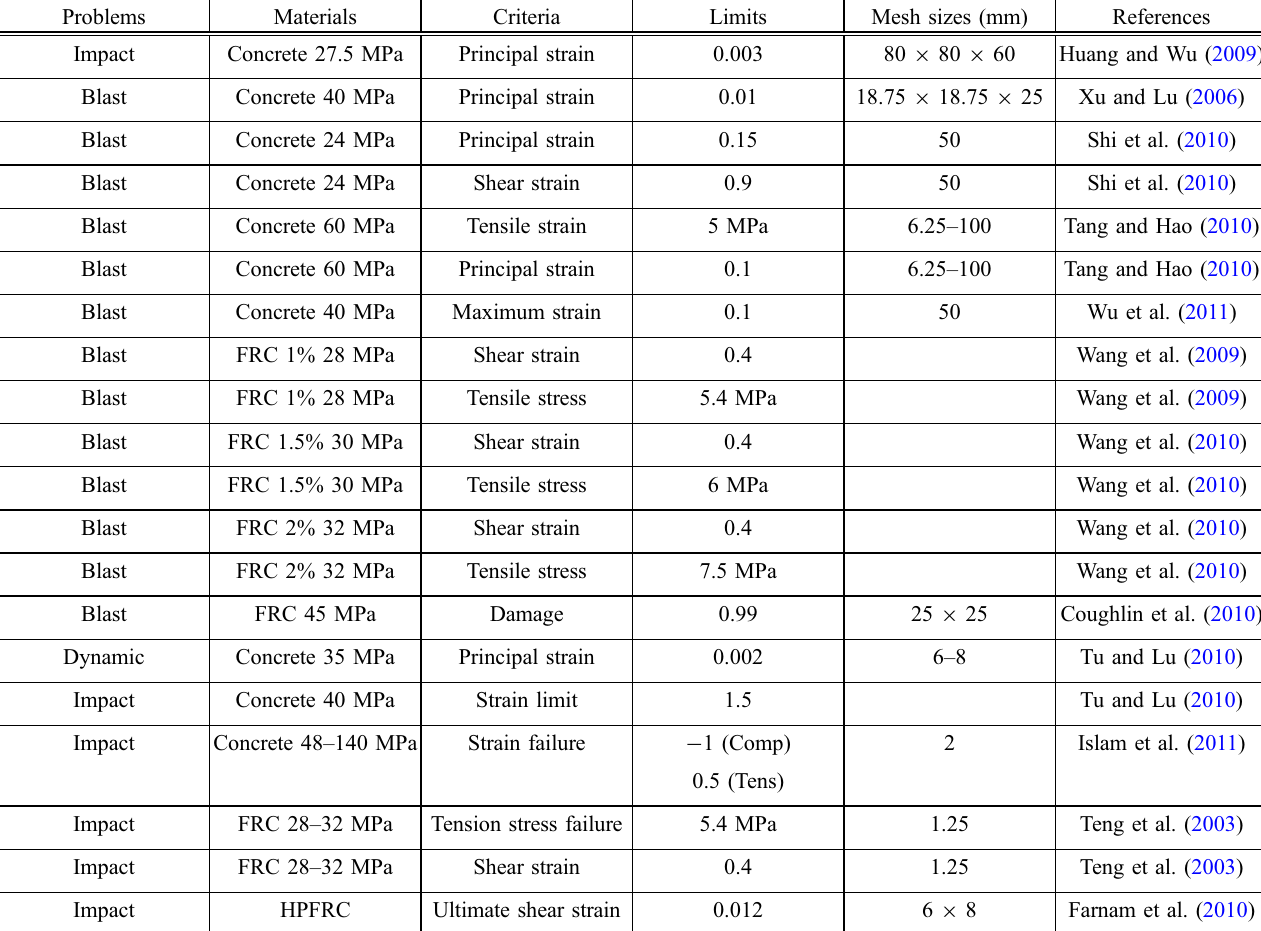
Table 5 Failure criteria in literature for concrete in LS-DYNA (Hallquist